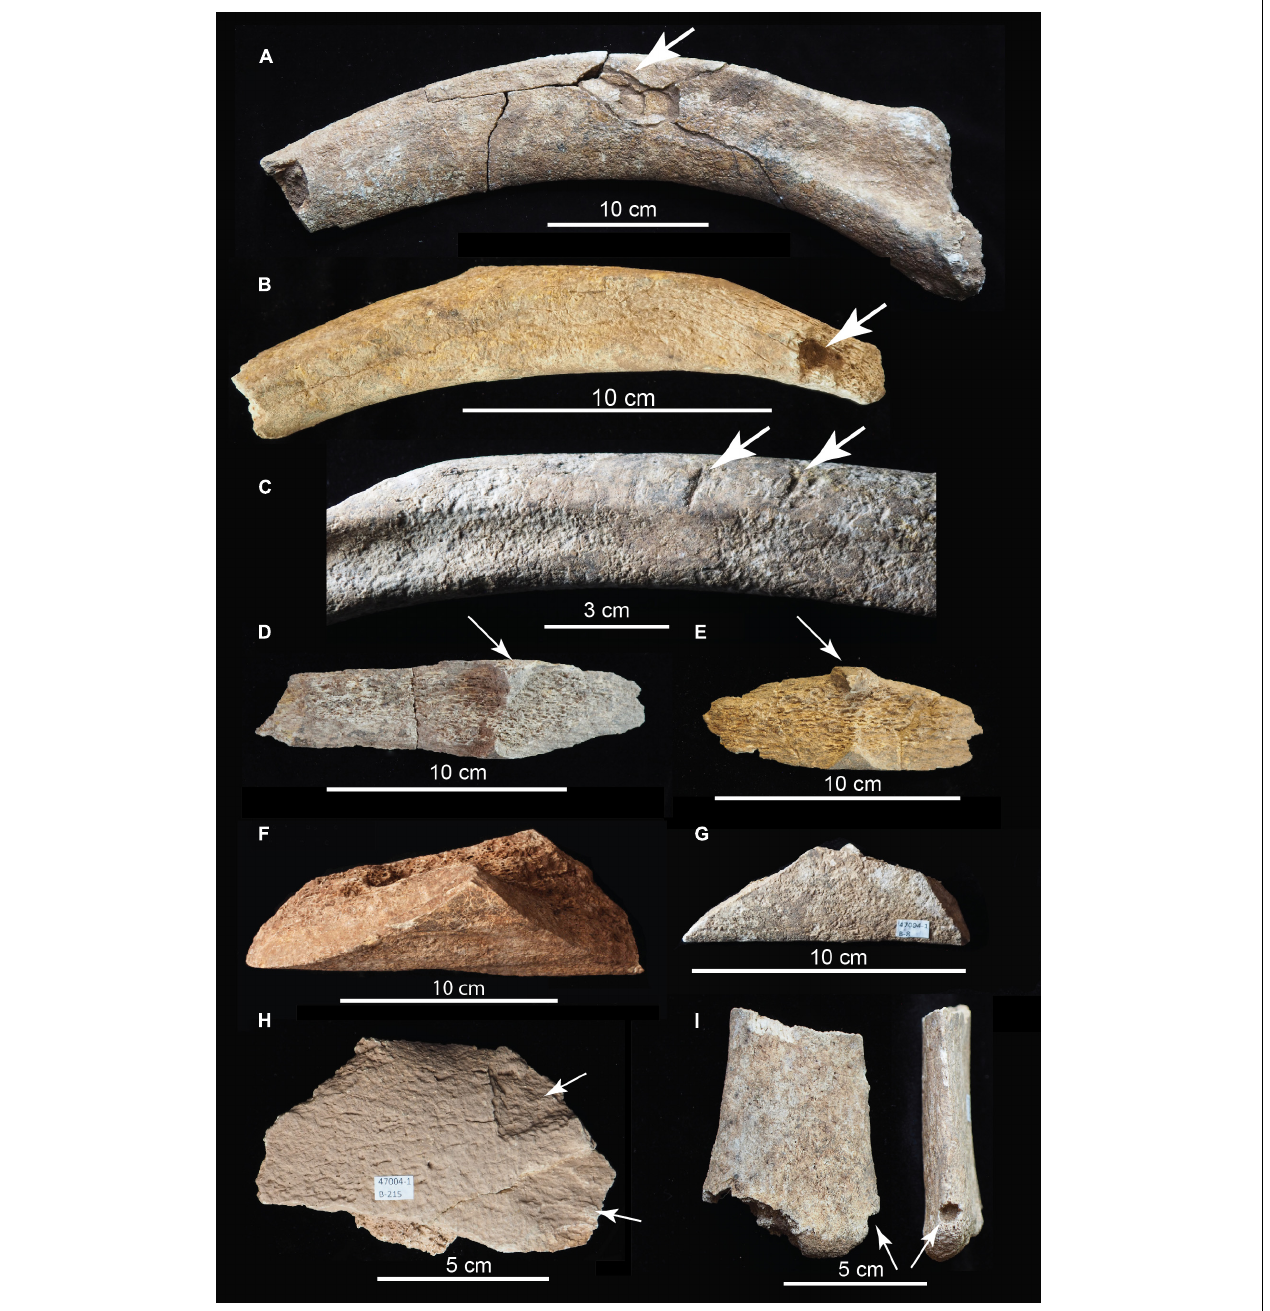
FIGURE 6 | Photographs of modified bones of adult Hartley mammoth. (A) Anterior rib with depressed blunt force impact wound (TMM 47004-1.1). (B) Mid-thoracic rib showing large-gauge puncture wound to capitulum (TMM 47004-1.36). (C) Mid-thoracic rib with parallel chop marks (TMM 47004-1.37). (D,E) Rib butterfly fragments (TMM 47004-1.152 and 47004-1.201). (F) Butterfly fragment derived from ulna or tibia (TMM 47004-1.40). (G) Rib butterfly fragment (TMM 47004-1.8). (H) Dentary bone flake with two secondary flake scars (TMM 47004-1.215). (I) Distal rib in two views showing puncture in-filled with sediment (TMM 47004-1.163) ( Supplementary Video 9